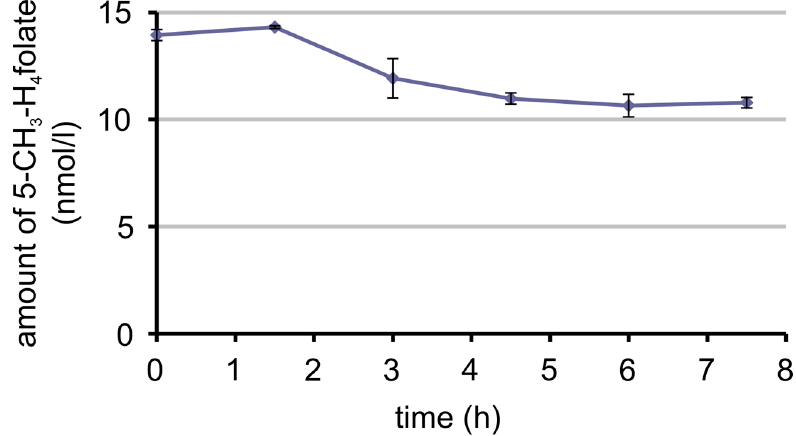
Figure 11. Amount of 5-CH 3 -H 4 folate in plasma (heparin plasma) over time after ingestion of couscous (rich in MeFox, low in folate).